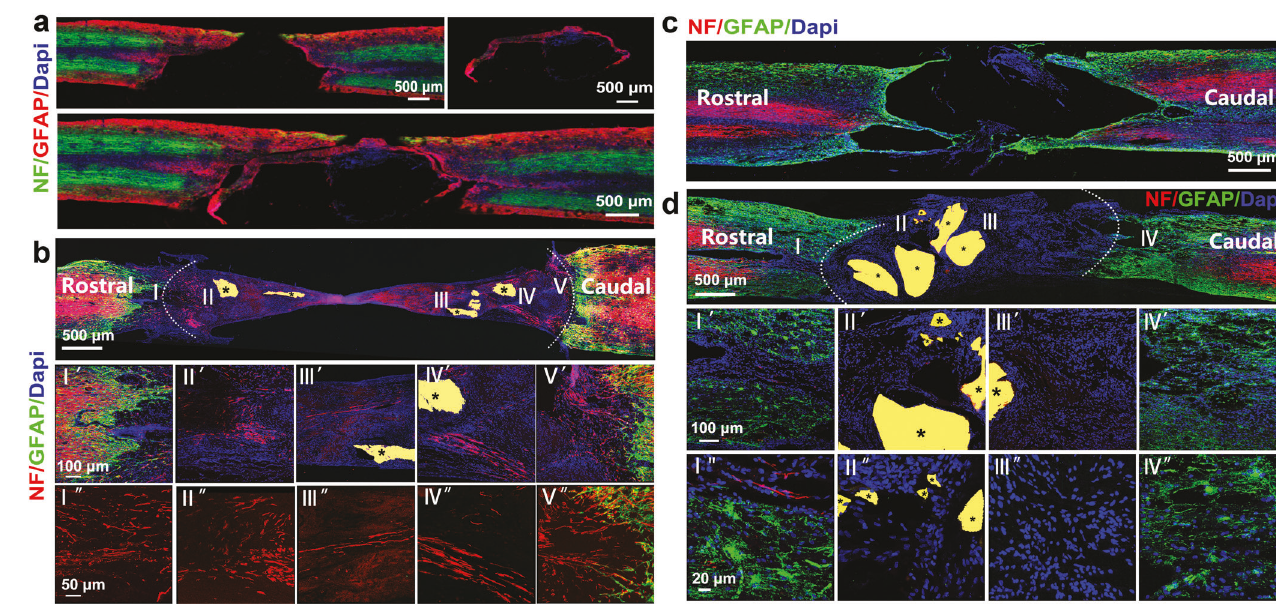
Fig. 7 Improving the microenvironment in the damaged area can promote nerve regeneration. a Immunographs of NF and GFAP-positive nerve fi bers during the second operation immediately. The small image on the right shows the scar tissue that has been cut off. The following diagram shows a reconstruction of the scar back to the cord. b Immunographs of NF and GFAP-positive nerve fi bers in the regenerating nerve tissues of groups at 3 mo after the second operation. A mass of neuro fi lament staining (red) detected in regenerated neural tissues. c Immunographs of NF and GFAP-positive nerve fi bers in chronic-SCI rats before aspiration of the cystic tissues at 3 mo post the fi rst operation. d Immunographs of NF and GFAP-positive nerve fi bers in aspiration-only rats with materials treatment at 3 mo after the second operation. No NF-positive (red) nerve fi bers were found in this group. *Labels undegraded chitosan biomaterials. Serially ampli fi ed images of highlighted